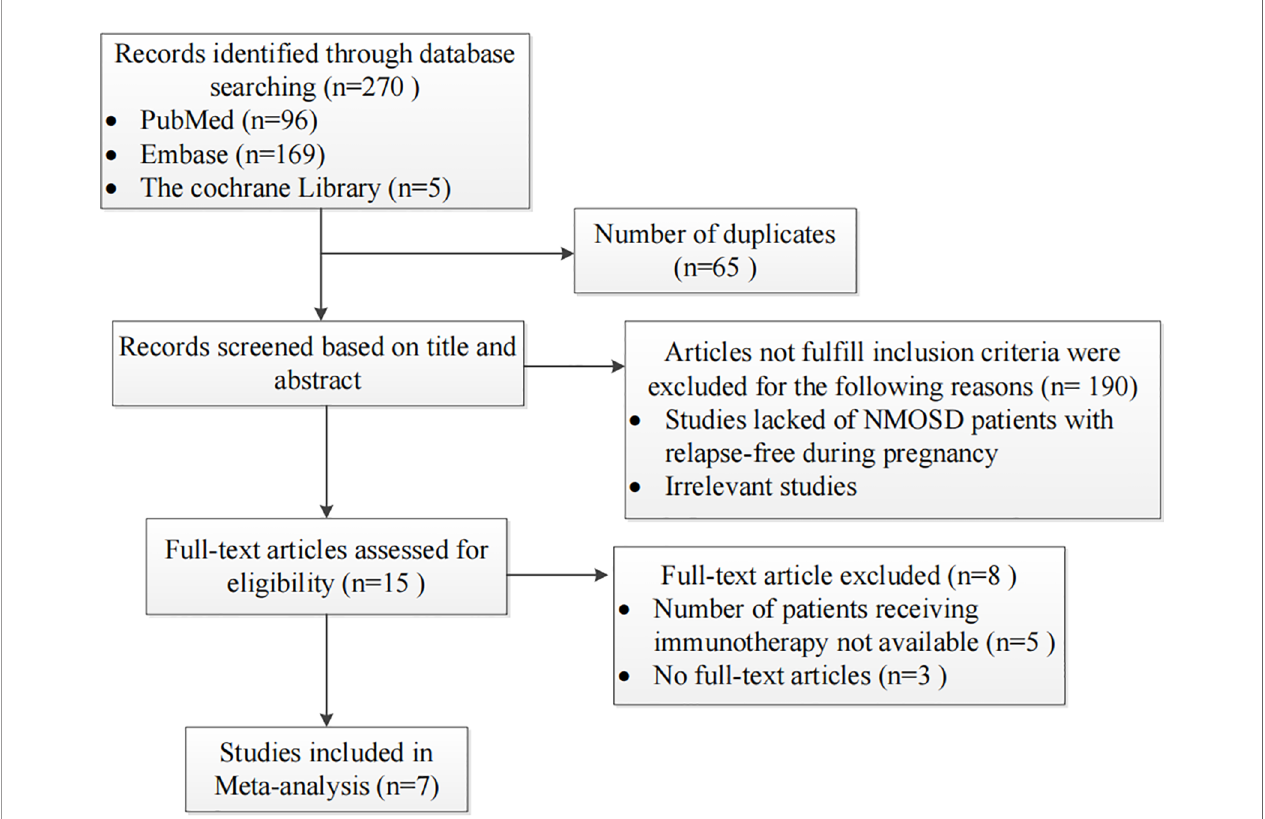
FIGURE 1 | Flow chart presenting the process of study selection for the pregnancy-related neuromyelitis optica spectrum disorder (NMOSD)